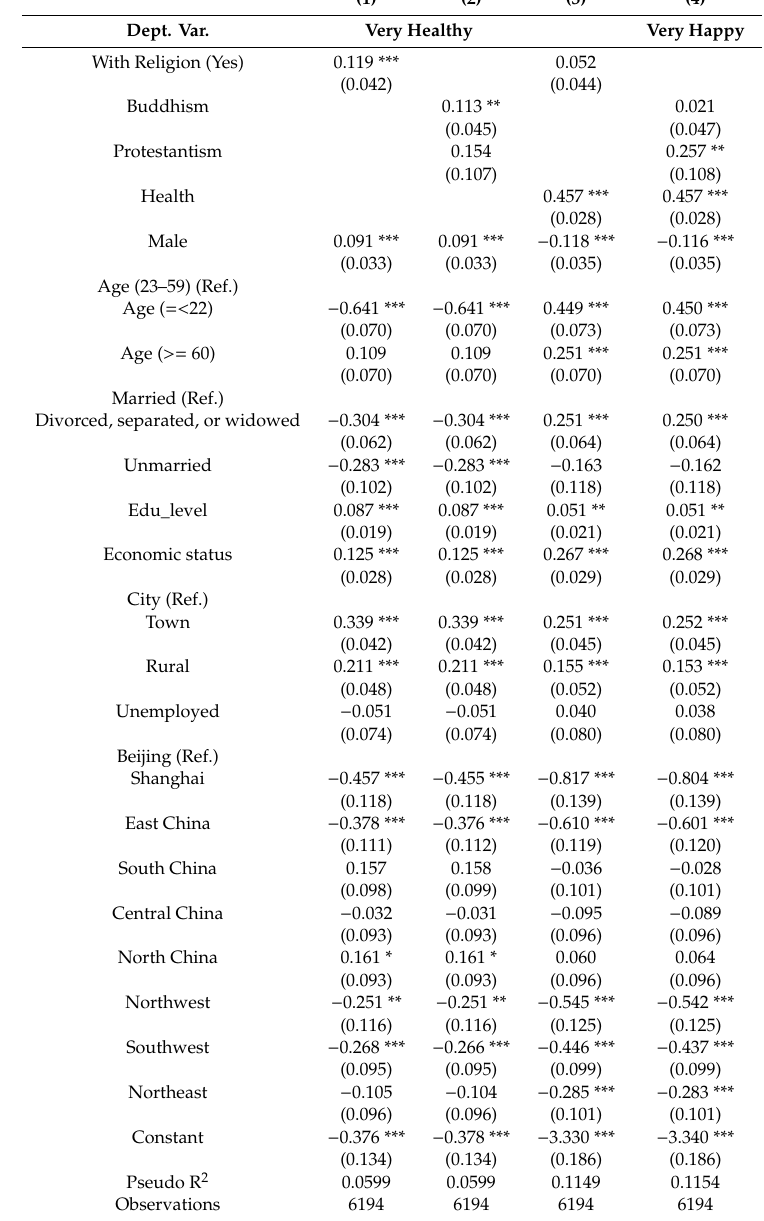
Table 2. Association between self-reported health and religion (Binary probit